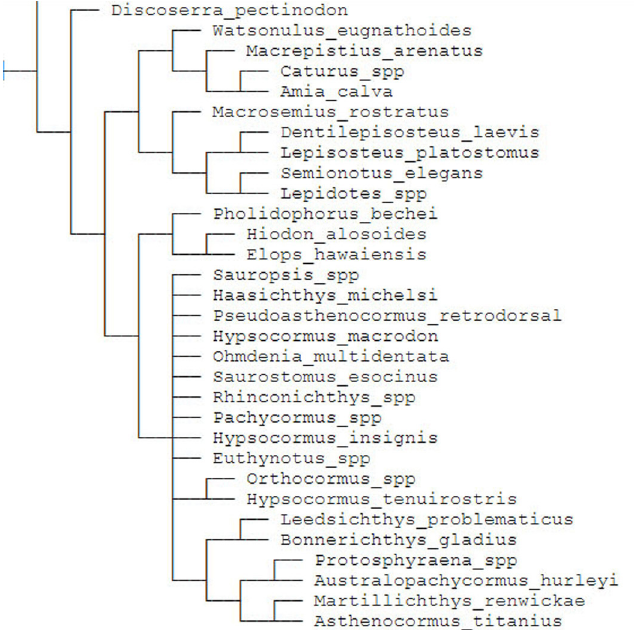
Figure 1. Strict consensus tree derived from 132 character 32 taxon dataset. Note classic topographic split between carnivorous and suspension-feeding tribes (Liston & Friedman 2012).